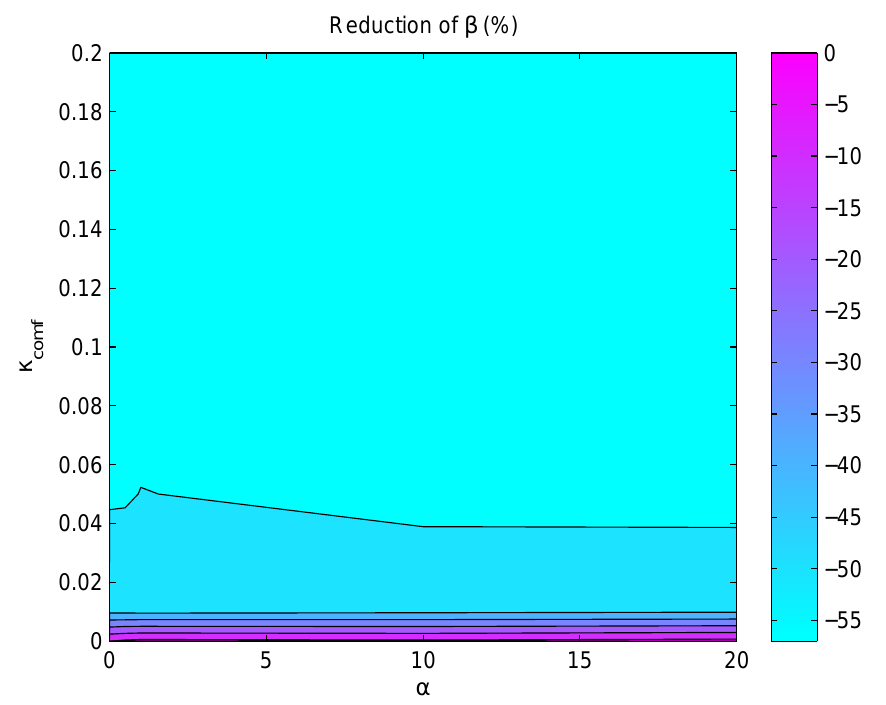
Figure 9. The effect of α and κ on the drivability variation β relative (%) to the value comf = 0 (reference point). computed for α = κ comf